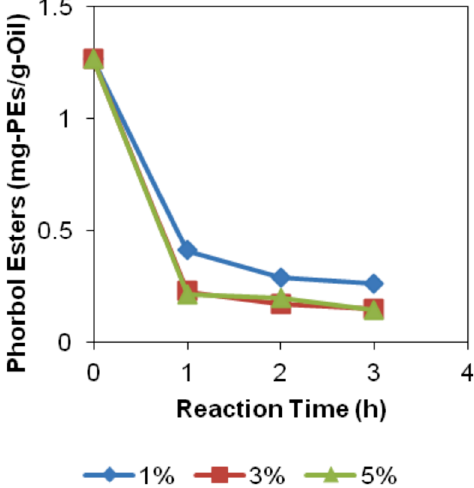
Fig. 2. Time course of FAME yield and phorbol esters in BDF in solid alkaline catalyzed transesteri fi cation (NaOH 0.5%).